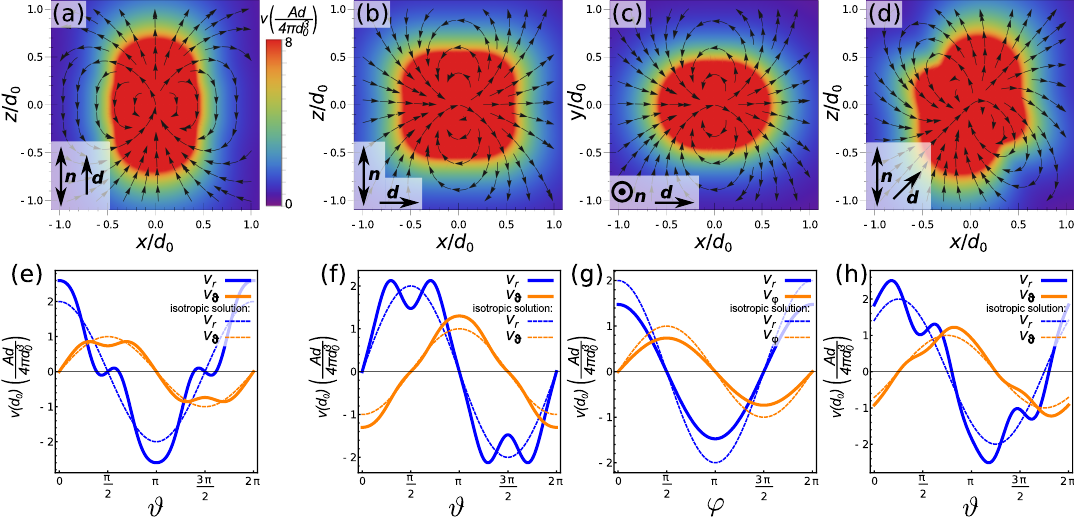
Figure 6. Flow field of source dipole in nematic (Equation (48)) for the dipole aligned ( a ) parallel to the director; ( b , c ) perpendicular to the director, and ( d ) at angle 45 ◦ to the director. The bottom row shows radial and azimuthal (or polar) components of the velocity field compared to the solution for isotropic fluid ( α 1 = α 6 = 0) for each of the cases above. Spreading of the velocity magnitude along the director is